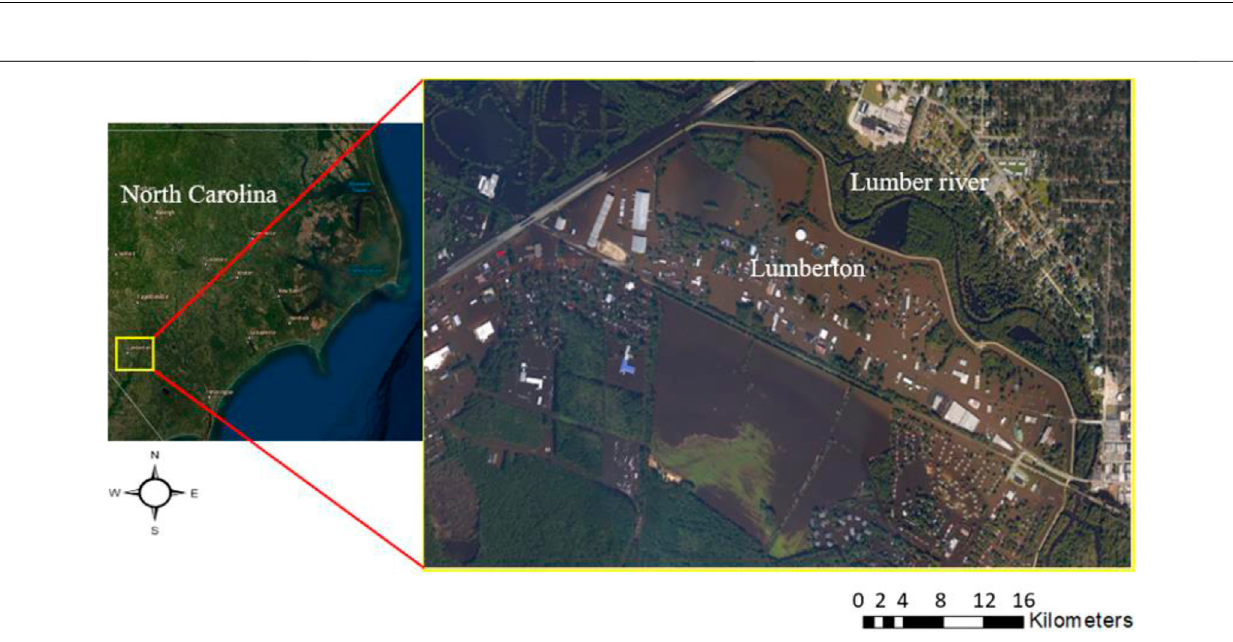
Frontiers in Remote Sensing |